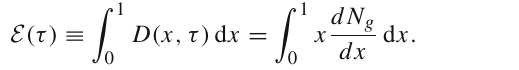
and for ˆ q ( t ) given by Eq. (12) we